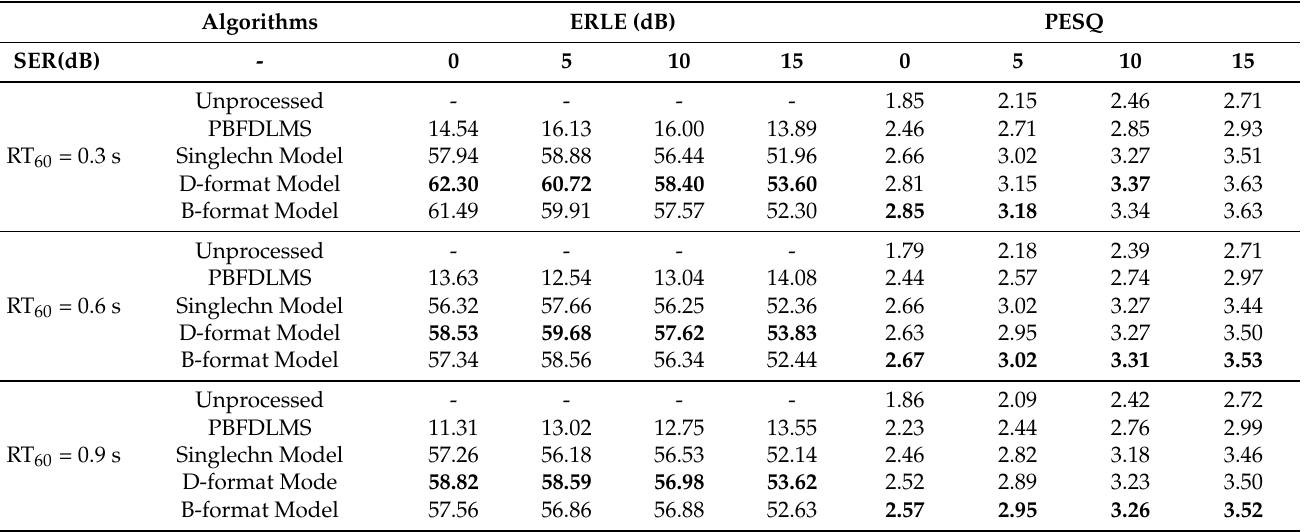
Table 2. Performance comparisons among different algorithms in different SERs and the standard surround set-up conditions.